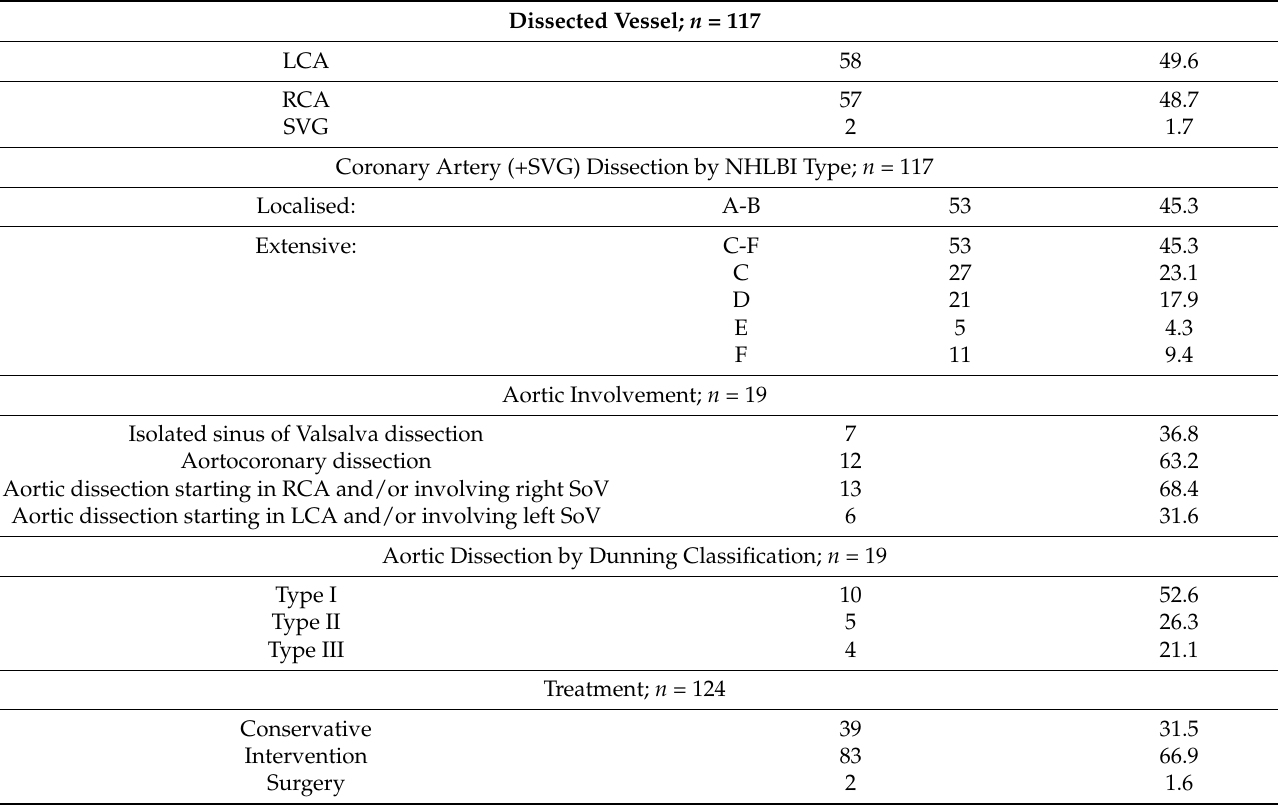
Table 1. Dissection characteristics.